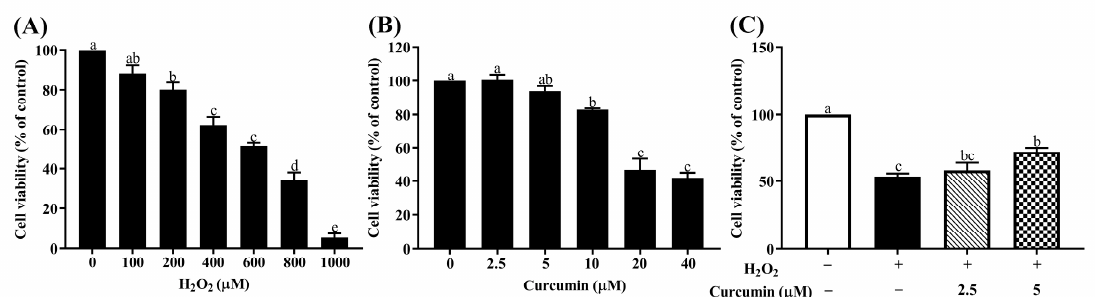
Figure 1. Effects of curcumin on H 2 O 2 -induced cell viability in HTR8/SVneo cells measured by the CCK-8 assay; ( A ) Cell viability of HTR8/SVneo cells treated with different concentrations of H 2 O 2 ; ( B ) cell viability of HTR8/SVneo cells treated with different concentrations of curcumin; ( C ) cell viability of HTR8/SVneo cells pretreated with 2.5 or 5 μ M curcumin against H 2 O 2 -induced oxidative stress. Data are presented as the mean ± SEM ( n = 3) a, b, c Means with different letters are significantly different ( p < 0.05).